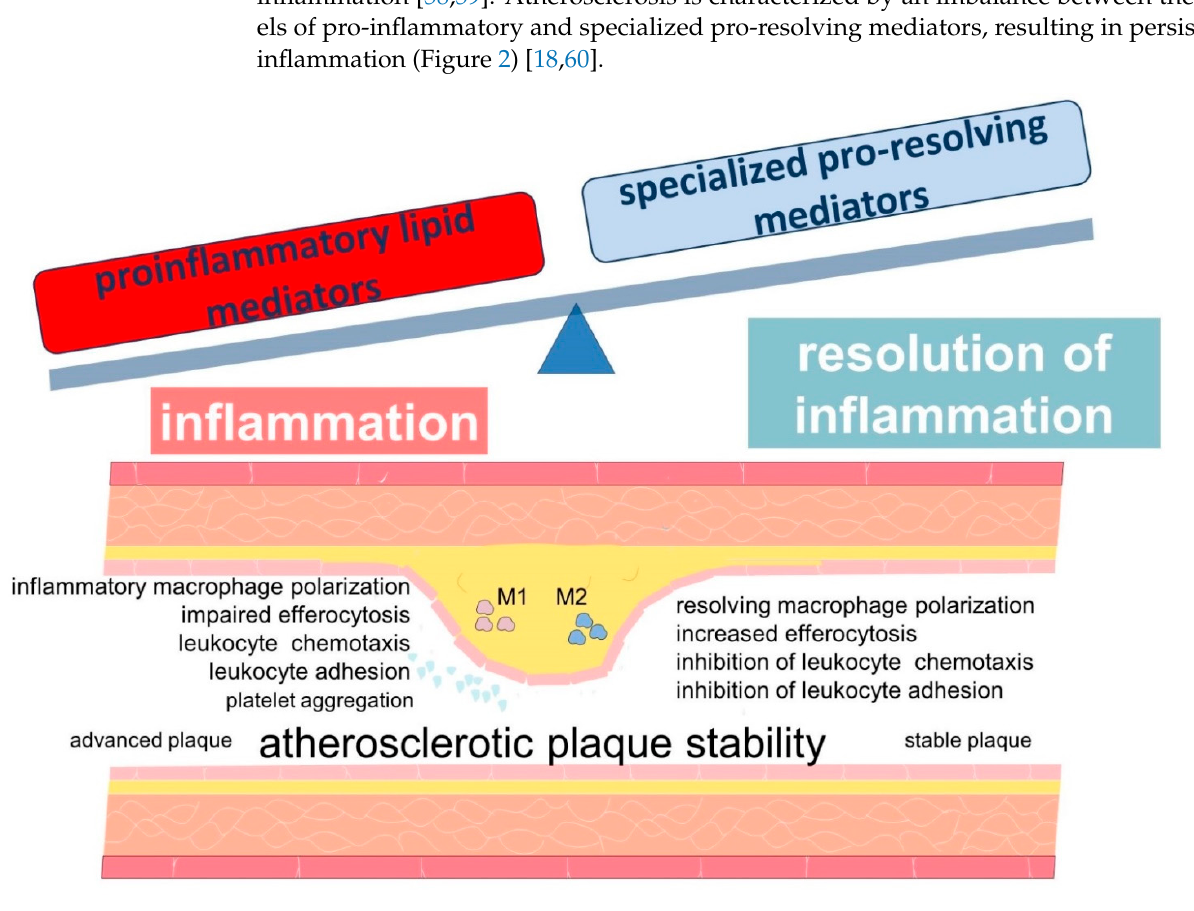
Figure 2. Scheme demonstrating the role of lipid mediators in the development of inflammation in atherosclerosis. The development and progression of atherosclerosis are associated with an imbalance between inflammation and inflammation resolution. Lipid mediators derived from PUFAs are involved in these processes.